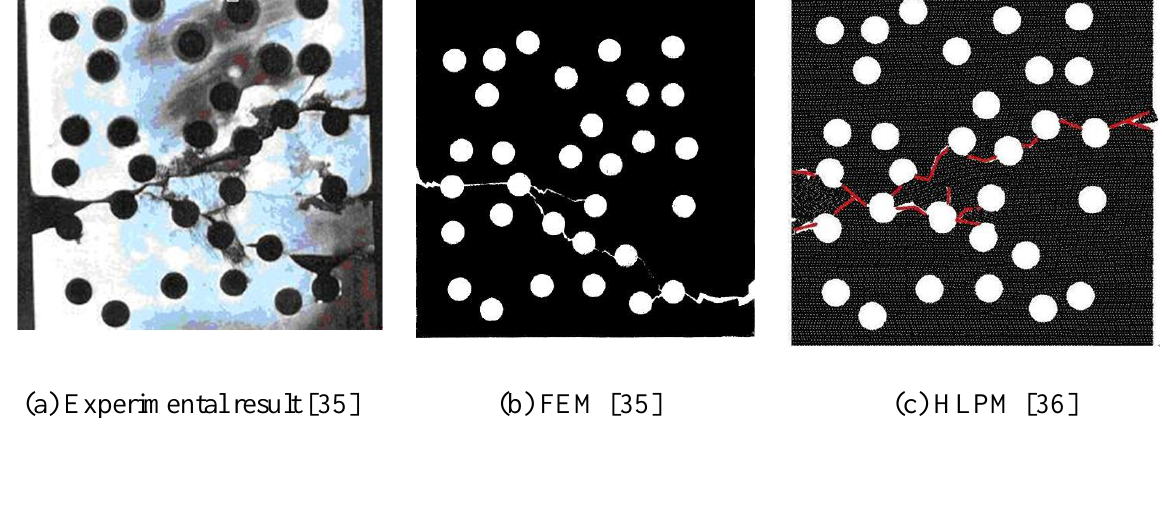
Figure 7. Experimental and modelling results of epoxy in tension, (a) experiment [35], (b) FEM [35], and (c) HLPM simulation